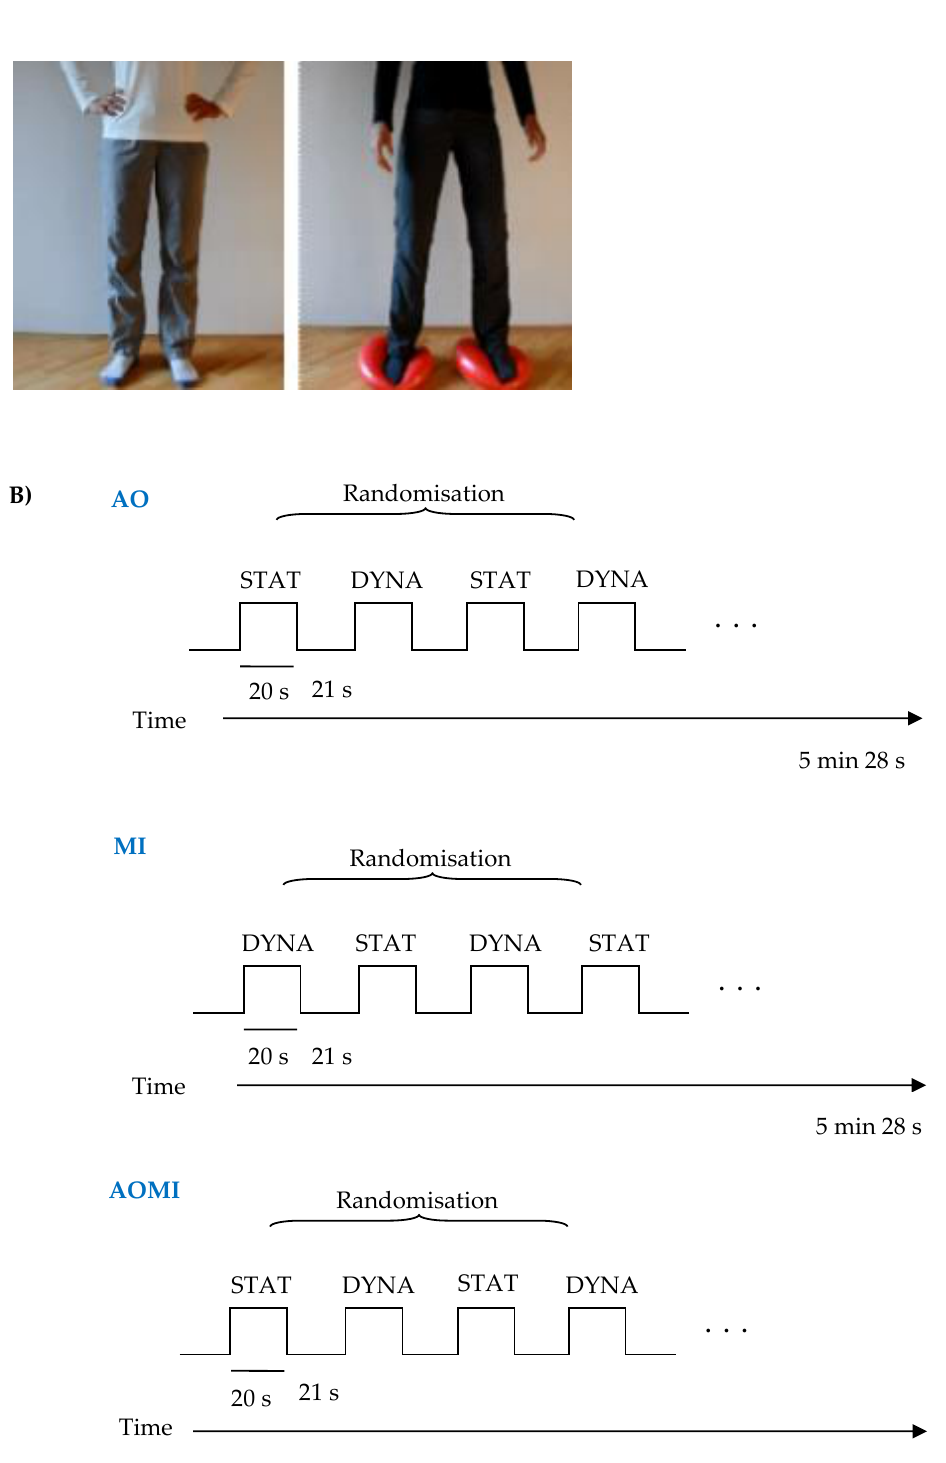
Figure 1. Experimental design. ( A ) Display of the static and dynamic balance task, respectively. ( B ) Scheme of the study performed with functional magnetic resonance imaging (fMRI). AO—action observation, MI—motor imagery, AOMI—motor imagery with action observation, STAT—standing position without moving, DYNA—participant had to balance on two balance